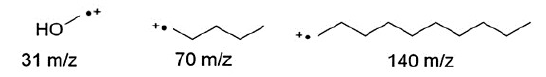
Figure 2. Main fragments arising from the cleavage or breakage of the alcohol chain in the esters formed. Methyl esters lose the alcohol chain as methanol (31 m / z ) thus forming an acylium ion. Pentyl and decyl esters undergo the loss of the alkyl chain (70 m / z for pentyl and 140 m / z for decyl esters) from the alcohol side forming an enolate ion.